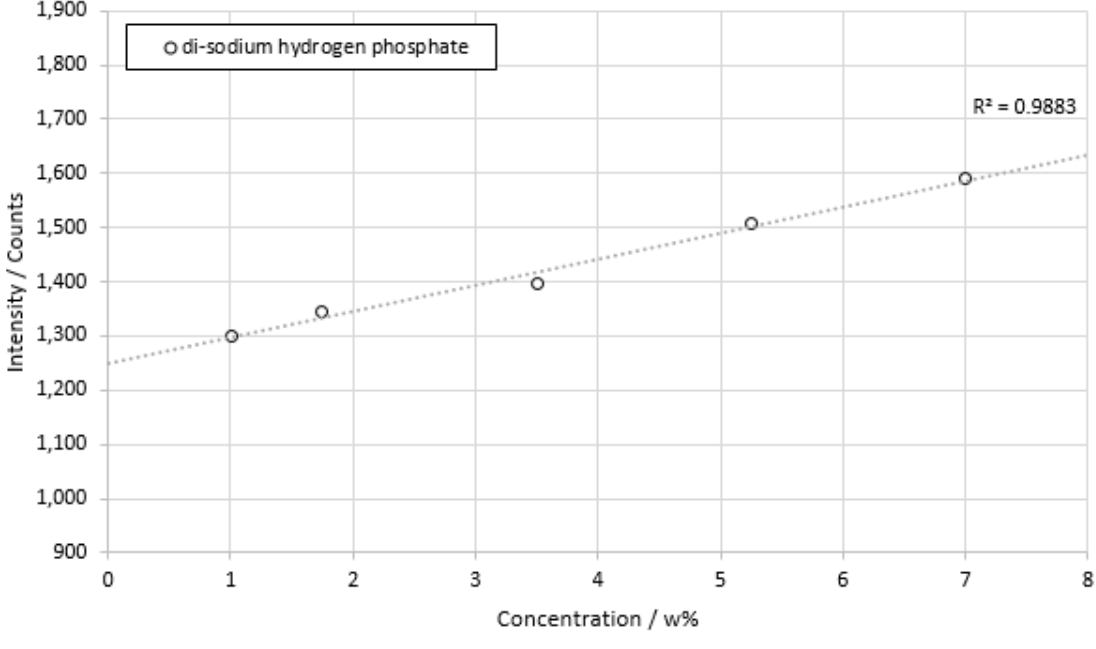
Figure 11. Concentration series of di ‐ sodium hydrogen phosphate dissolved in deionized water. The integration time is 100 ms. Each concentration was measured for about a time of 2 min.